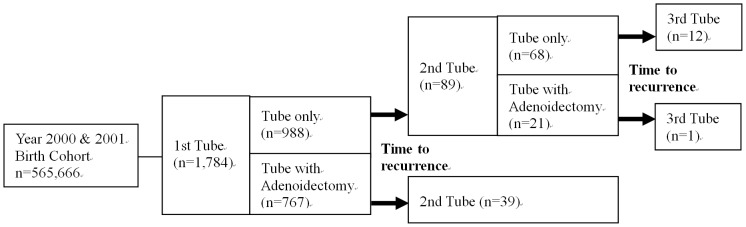
Study flow chart.